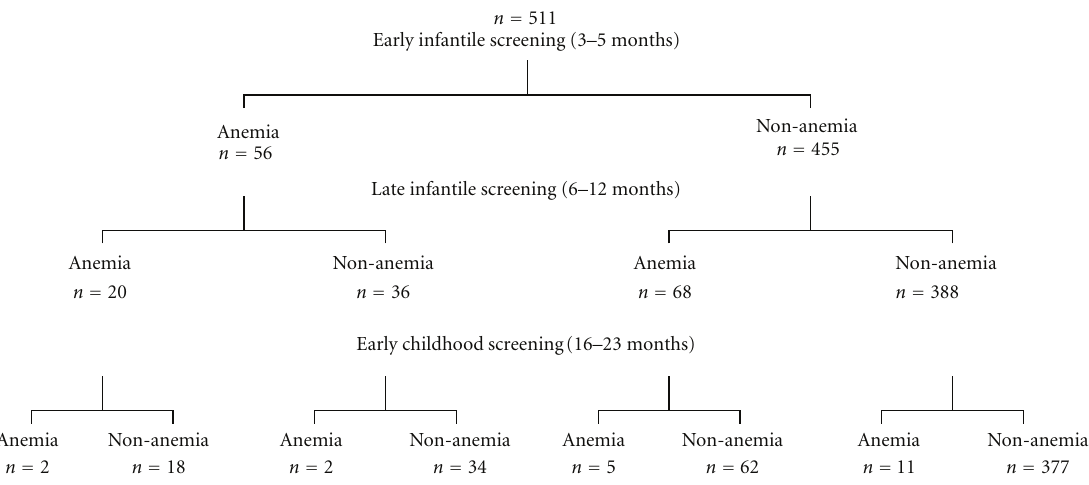
Figure 1: Flowchart of the anemia screening program in the Okinawan village for the cohort